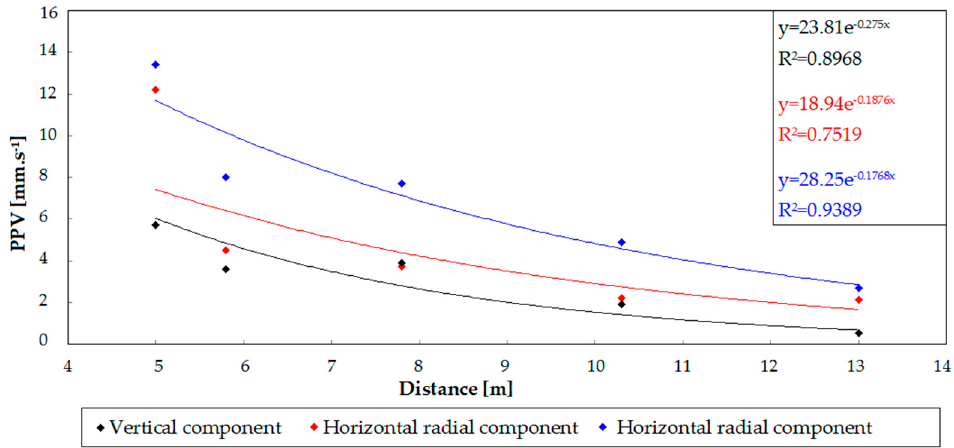
Figure 6. Attenuation curves for the given environment acquired pursuant to in situ measurements— vibrated gravel piles.